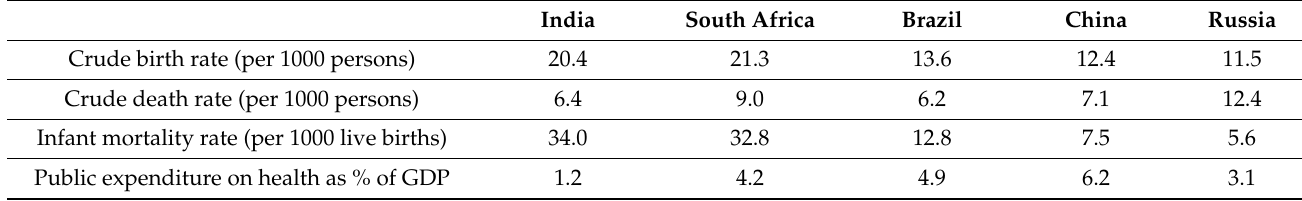
Table 1. Socioeconomic indicators in the BRICS block as of